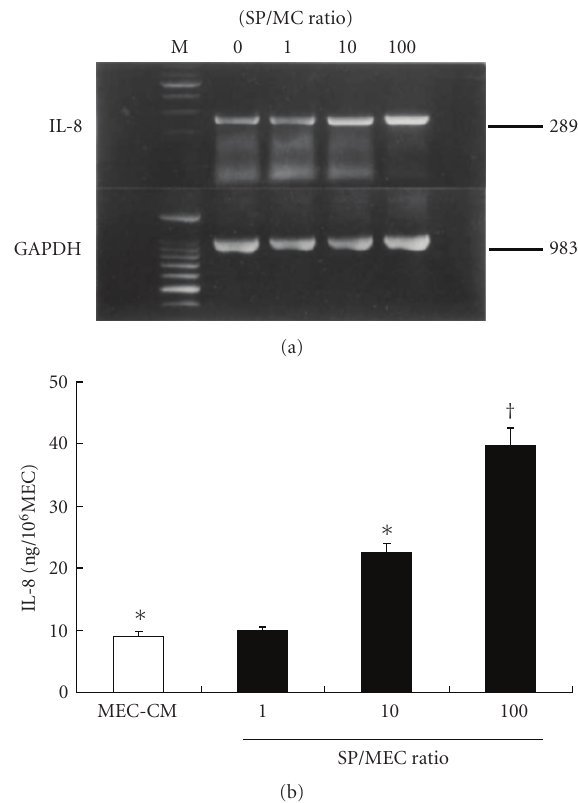
Figure 1: The kinetics of IL-8 with alteration of SP/MEC ratio. expression of IL-8. IL-8 mRNA expression (a) and secreted IL- 8 concentration (b) were significantly increased in the 10 and 100SP/MEC-CM compared with the MEC-CM in an SP number- dependent manner. ∗ , † P < .